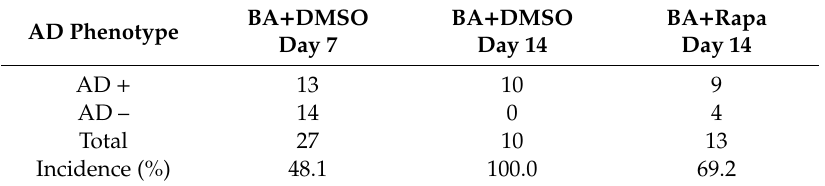
Table 3. Effect of the therapeutic intervention by rapamycin on the incidence of AD. Table 3. E ff ect of the therapeutic intervention by rapamycin on the incidence of AD.